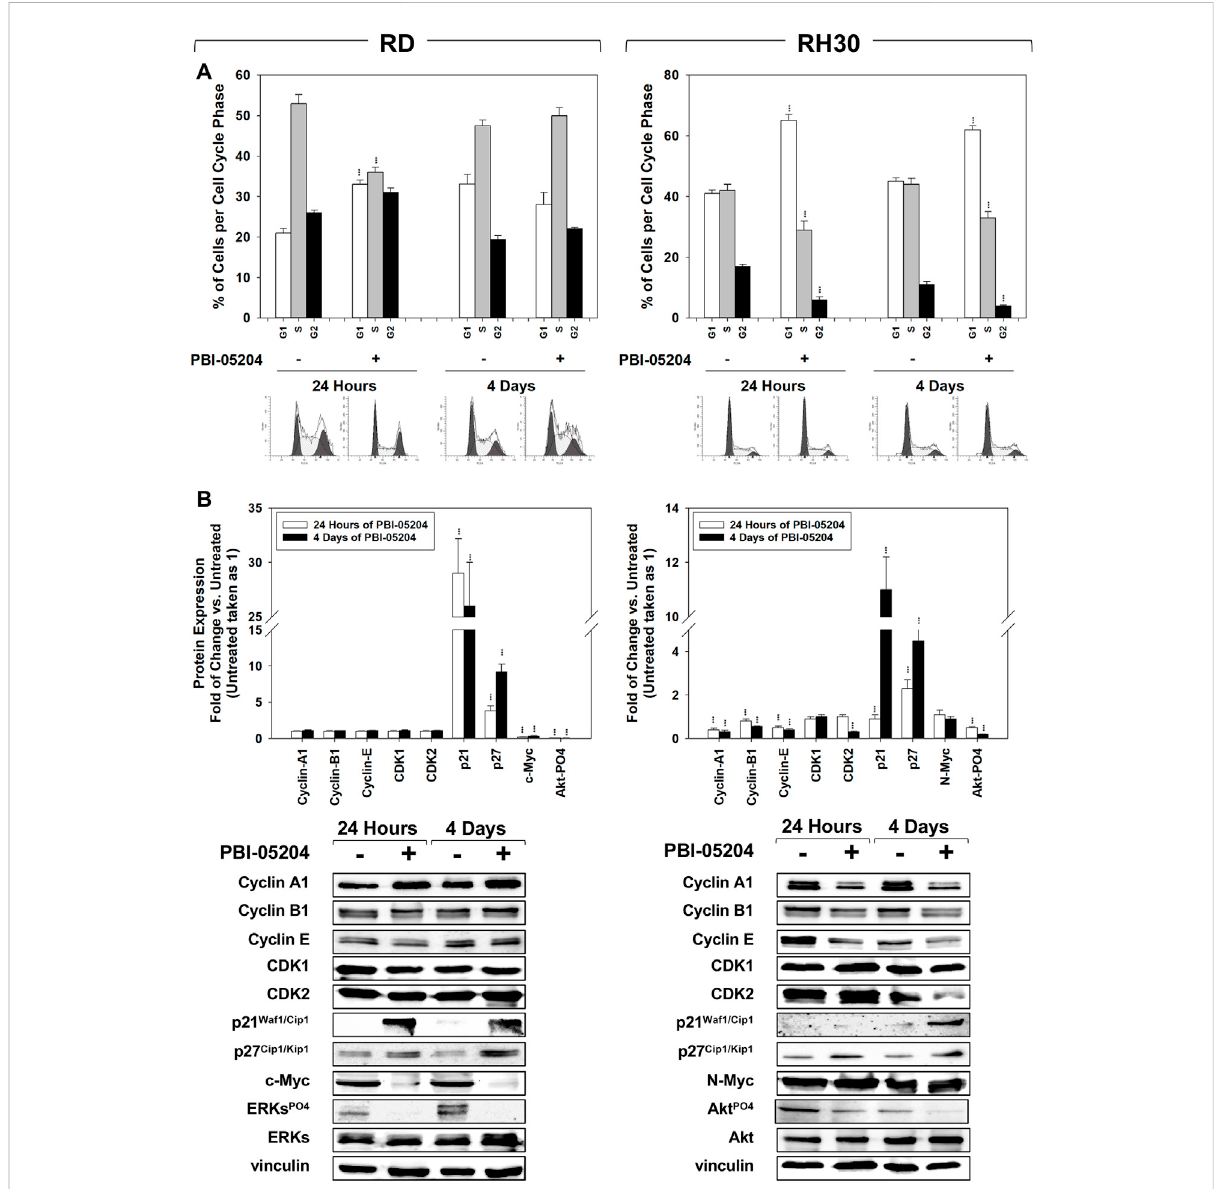
FIGURE 2 PBI-05204 affects cell cycle distribution. (A) FACS analysis performed on RD (Left) and RH30 (Right) untreated or treated for 4 with PBI-05204 (IC50). Data (Up) indicates the percentage of cells in each cell cycle phase representing the mean value of three independent experiments. (Down) Representative data of three independent experiments is shown. (B) Cell lysates from RD (Left) and RH30 (Right) cells treated for 24 h and 4 d with PBI-05204 (IC50) were analyzed by immunoblotting with speci fi c antibodies for the indicated proteins; vinculin expression was used as a loadingcontrol.Histograms(Up)ofdensitometricanalysisrepresentthemeanvaluesofthreeindependentexperiments±SD.Statisticalsigni fi cance: ** p ≤ 0.01, *** p ≤ 0.001 vs. Untreated cells. Representative data from three independent experiments is shown